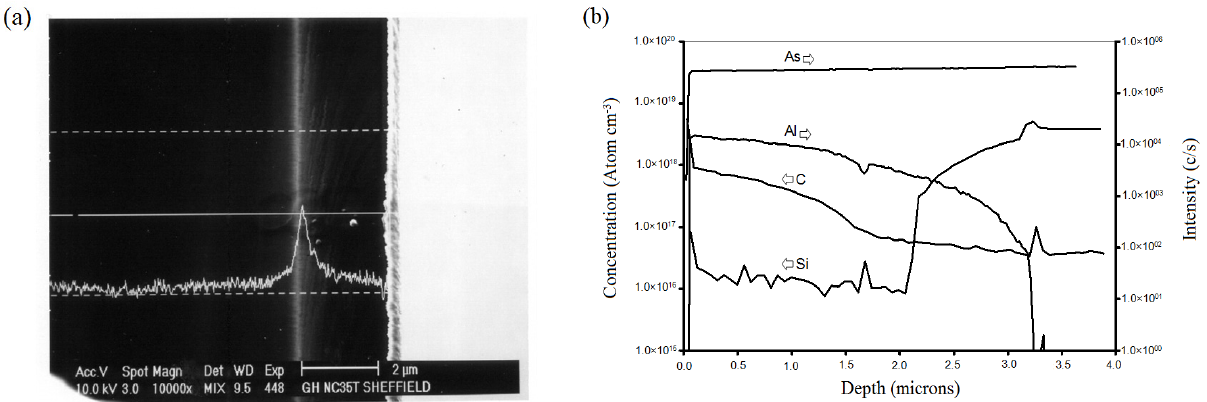
Figure 8. EBIC and SIMS profiles of graded bandgap solar cell structures showing n + and p + doping at the back and the front of the solar